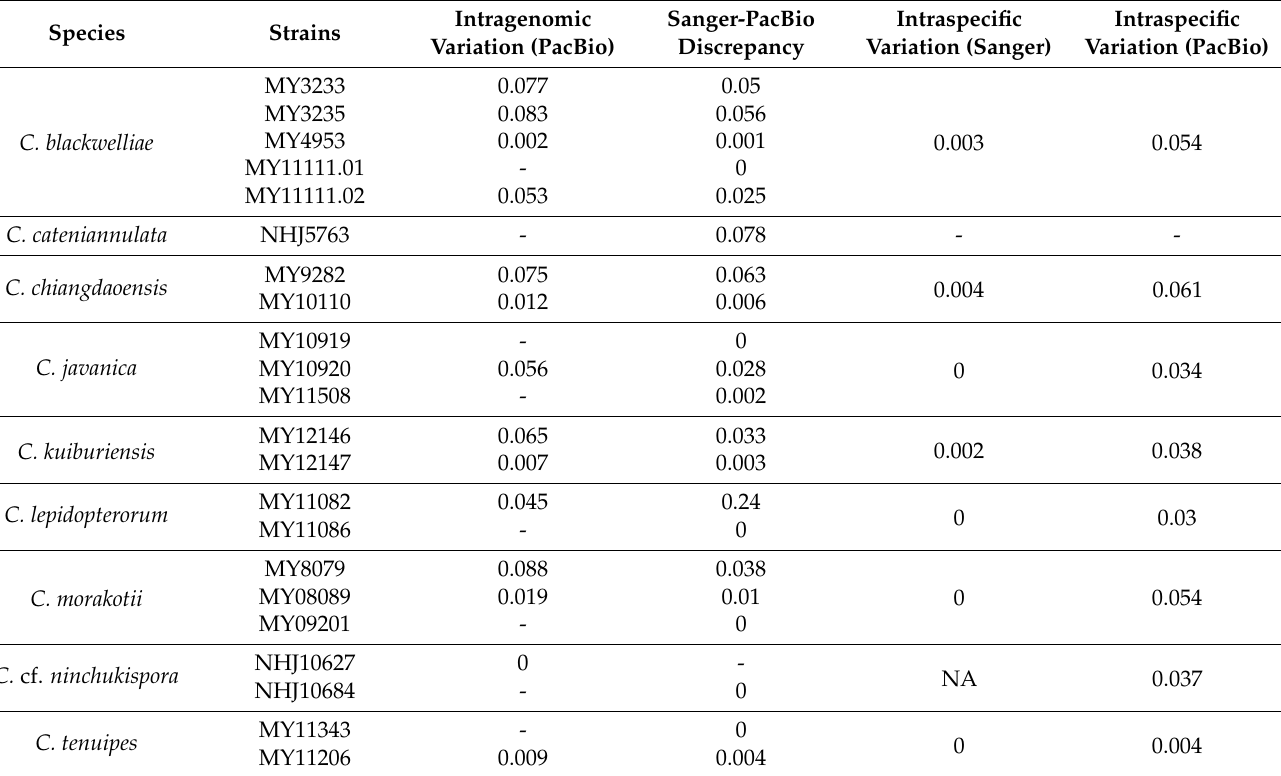
Table 2. Average p-distance within strain (intragenomic variation) and within the species (intraspecific variation).